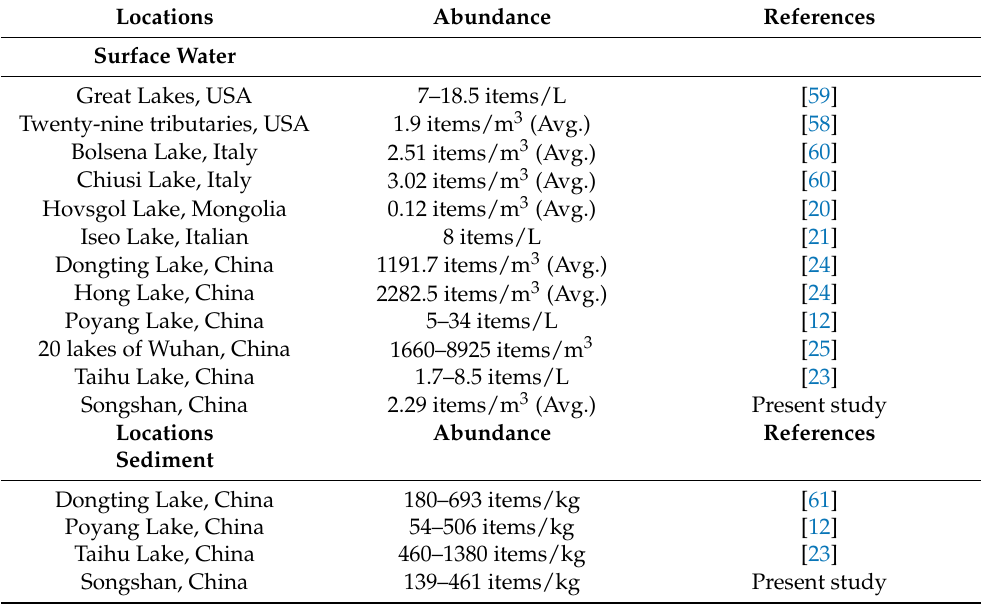
Table 3. Comparison of microplastic abundance in freshwater lake studies around the world. Avg. means the average abundance of